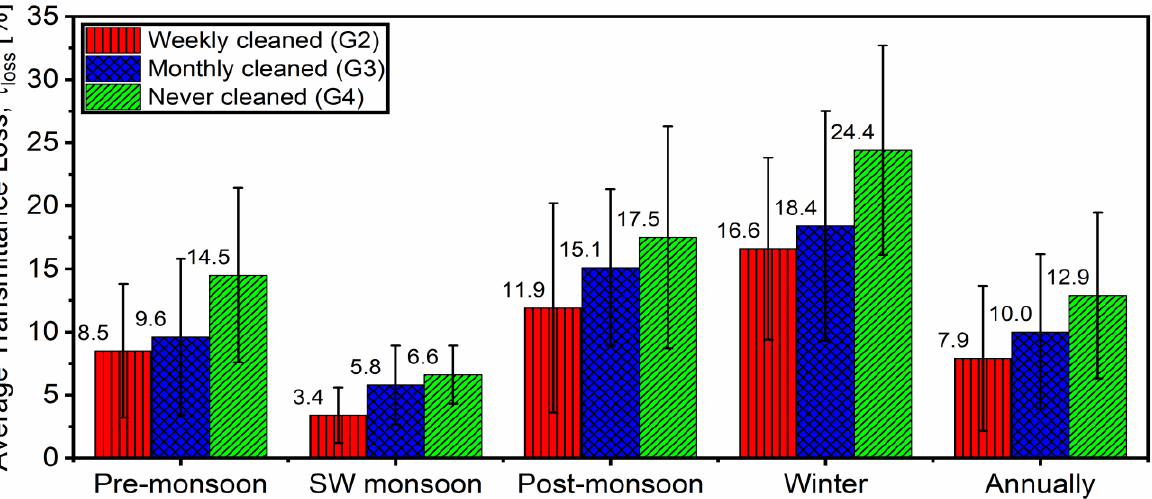
Figure 14. Seasonal average transmittance loss ( τ loss ) and the respective standard deviation (in %) of weekly cleaned (G2), monthly cleaned (G3), and never cleaned (G4) glass coupons during the four seasons.